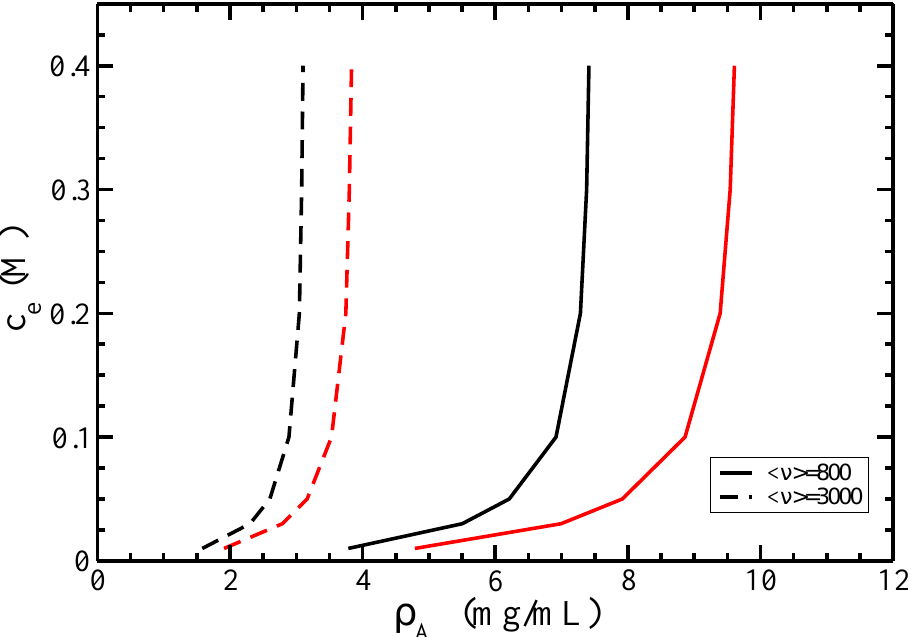
Figure 12. The isotropic–nematic phase diagram in terms of coexisting densities of actin ρ A for different values of the monovalent ions’ concentrations c e . The average lengths of filaments are < ν > = 800 (solid lines) and 3000 (dashed lines); the persistence length P = 18 µ m, and the normalized standard deviation σ = 0.5. The coexisting isotropic and nematic densities are plotted in black and red colors,